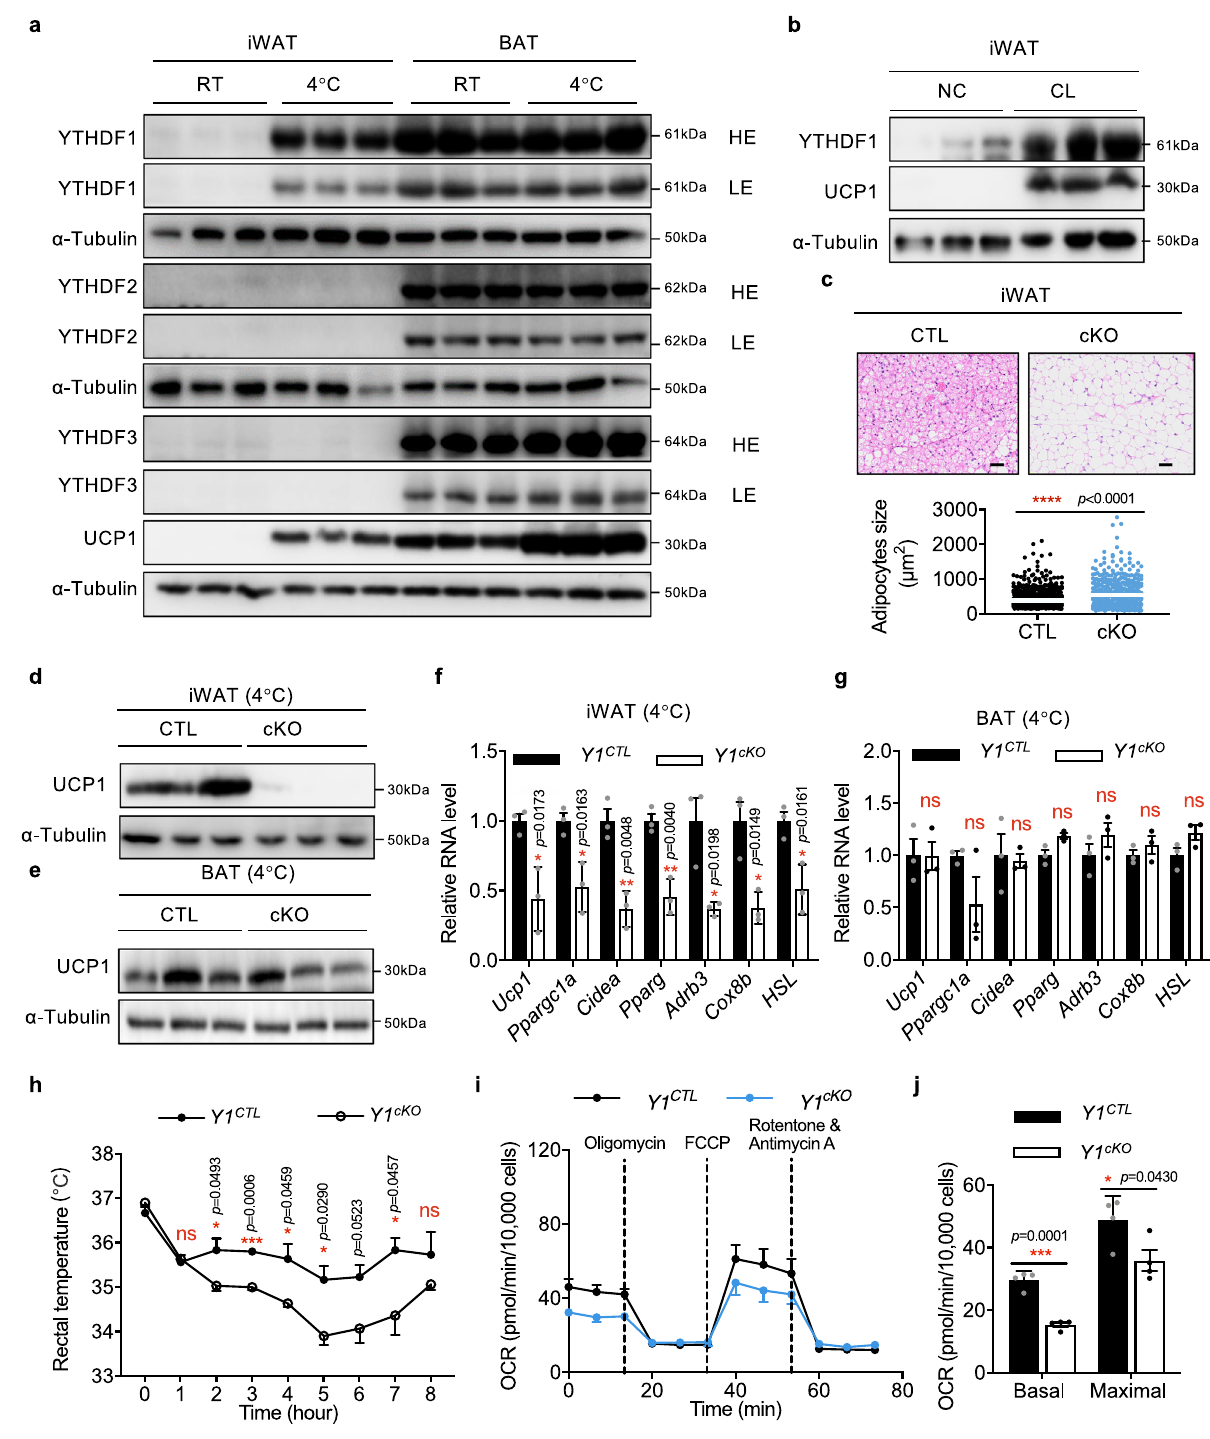
Fig. 3 | Adipocyte-speci fi c knockout of Ythdf1 inhibits beiging of iWAT. a Immunoblot analysis of YTH family proteins expression in iWAT and BAT from mice housed at room temperature (RT) or 4°C. b Immunoblot analysis of YTHDF1 and UCP1 expression in iWAT from mice treated with or without CL-316,243 (CL). c – g Y1 CTL and Y1 cKO littermates were exposed to cold conditions for 7 days. c H&E staining of iWAT. Scale bar, 50 μ m. The white line indicated the average size. No adjustments. d , e Immunoblot analysis of UCP1 in iWAT d and BAT e . f , g mRNA levelsofthermogenesis-and lipolysis-related genesiniWAT( f )andBAT( g )Datain f, g were presented as mean±SEM ( n =3 biologically indipendent mice). No